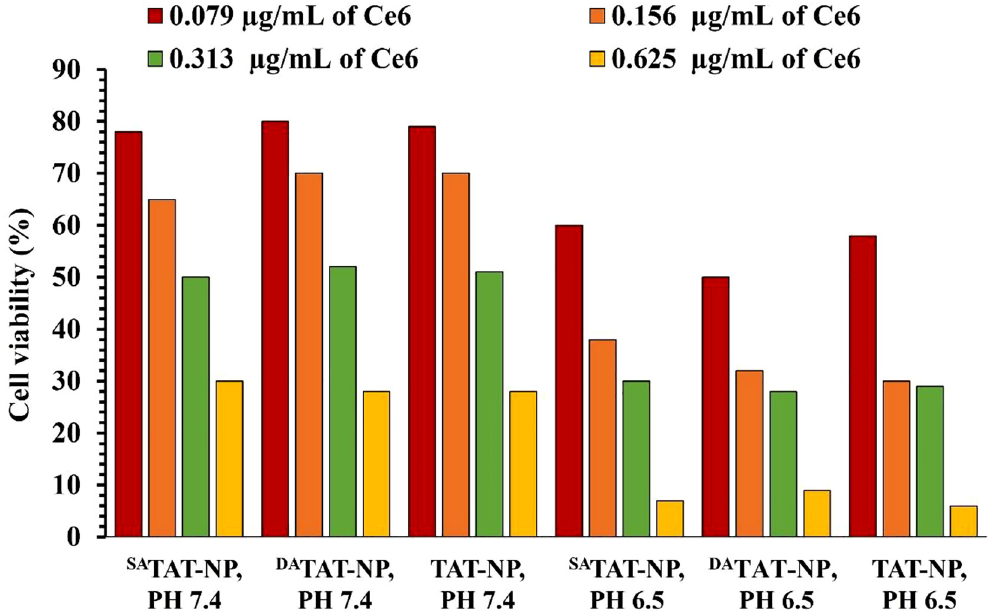
Figure 31: The cytotoxicity performance of DA TAT-NP, SA TAT-NP, and TAT-NP performance in BxPC-3 cells with NIR laser irradiation (660 nm, 0.5 mW cm − 2 ) for 20 min. Adapted from Gao et al.